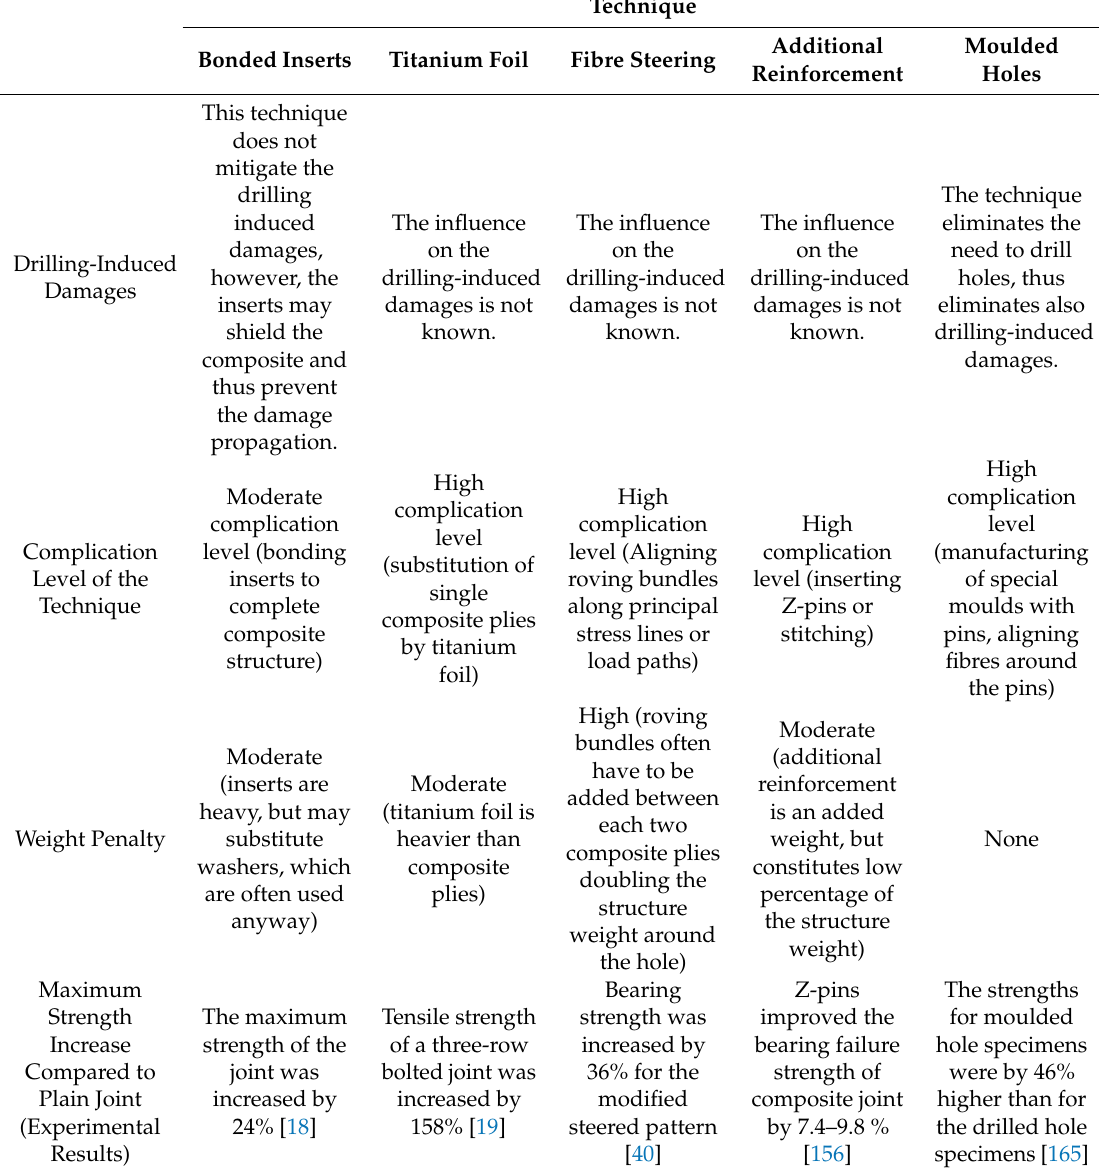
Table 6. Summary of techniques used to improve performance of bolted joints in composite